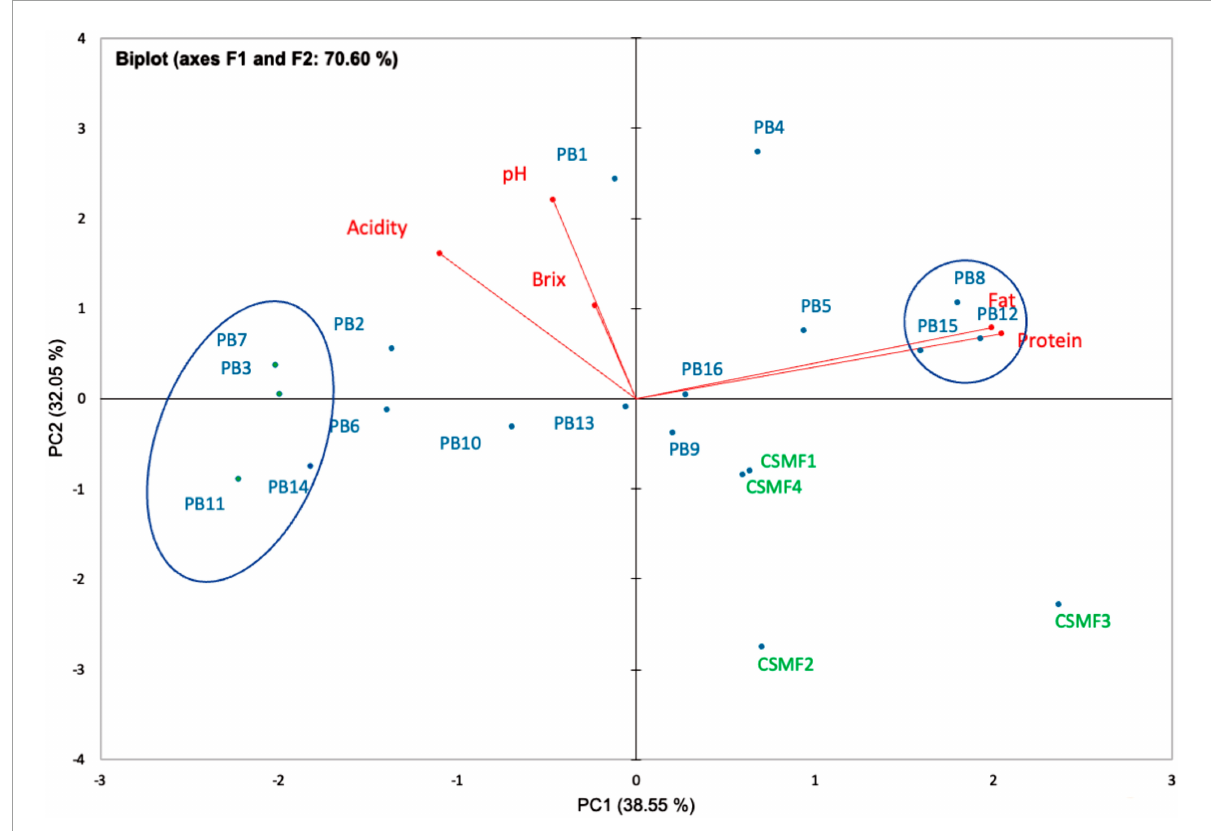
FIGURE5 Biplot PCA analysis of five variables (pH, titratable acidity, ◦ Brix, total protein content and fat) of PBs and CSMFs at day 21 of storage; the rectangles marked the close-related beverages. Legend: PB1–PB4: (CSMF1–CSMF4) + UTNGt2; PB5–PB8: (CSMF1–CSMF4) + UTNGt5; PB9–PB12: (CSMF1–CSMF4) + L.Lac; PB13–PB16: (CSMF1–CSMF4) + L.r. CSMF1: semi-skimmed milk + 1% cocoa + 2% glucose; CSMF2: semi-skimmed milk + 2% cocoa + 2% glucose; CSMF3: semi-skimmed milk + 3% cocoa + 2% glucose; CSMF4: semi-skimmed milk + 2%